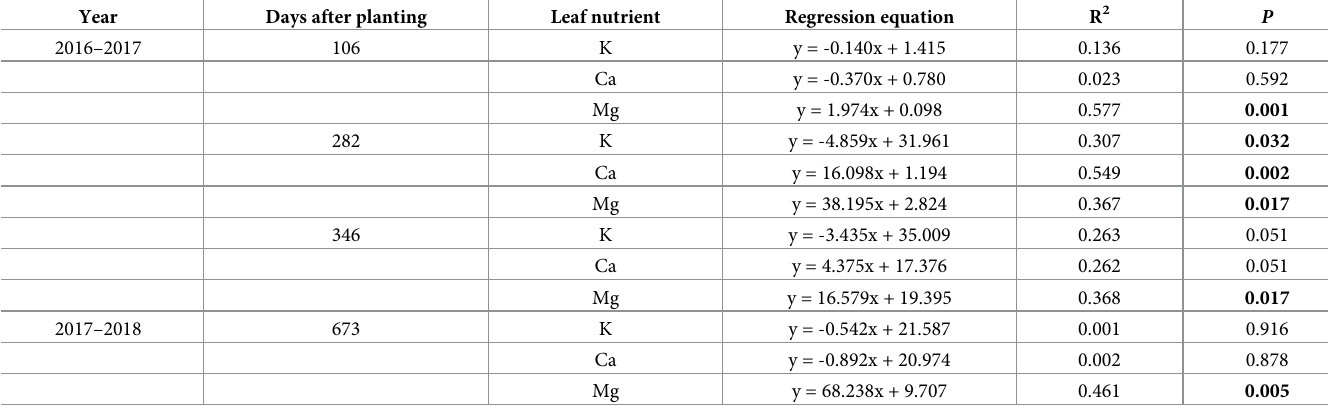
Table 1. Regression analysis between leaf nutrient concentration and shoot